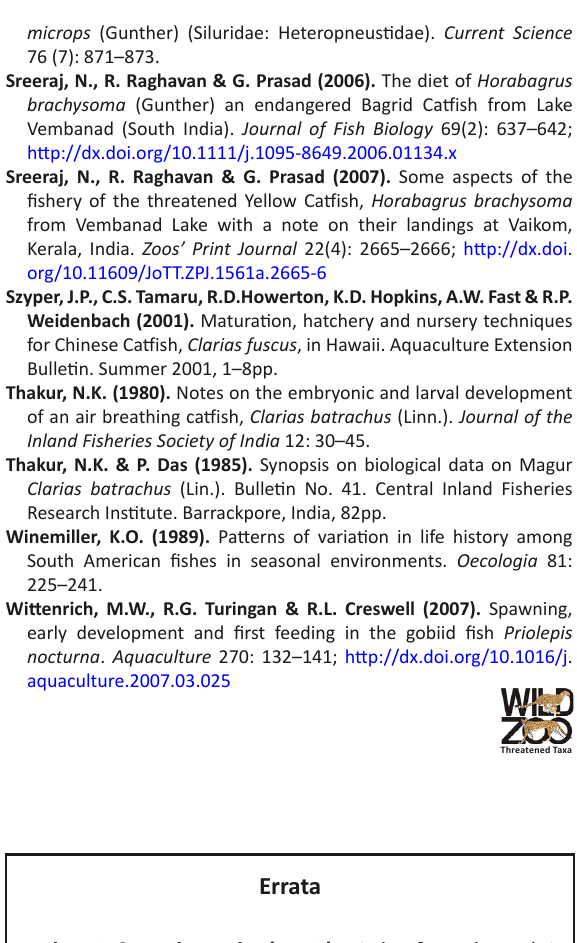
Page 4969 Table 1: The notation of Imae 2 to